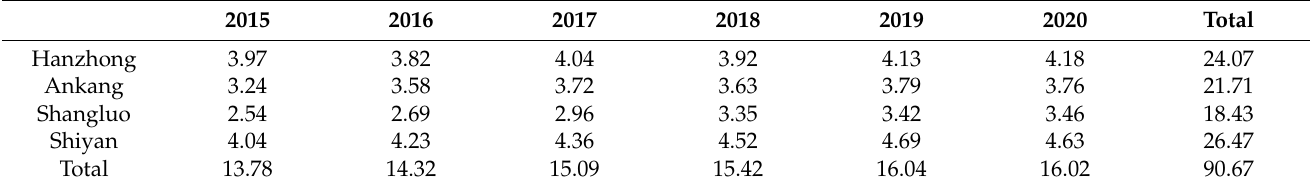
Table 3. The opportunity cost of secondary industry producers in the main headwater areas from 2015 to 2020 (100